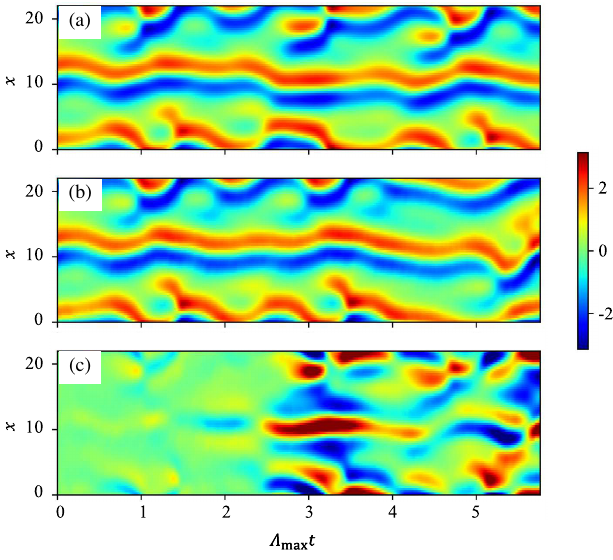
FIG. 3. Experimental Kuramoto-Sivashinsky spatiotemporal chaotic datasets prediction by optical reservoir computing. The spatial domain size of the chaotic system is L ¼ 22 . The number 10 4 . (a) Actual of the photonic nodes in the reservoir is D res ¼ data. (b) Reservoir prediction. (c) Error: (a) minus (b). t ¼ 0 corresponds to the start of the prediction in the test phase. Each unit on the temporal axis represents the Lyapunov time defined by the largest Lyapunov exponent Λ and detailed in Appendix C. max